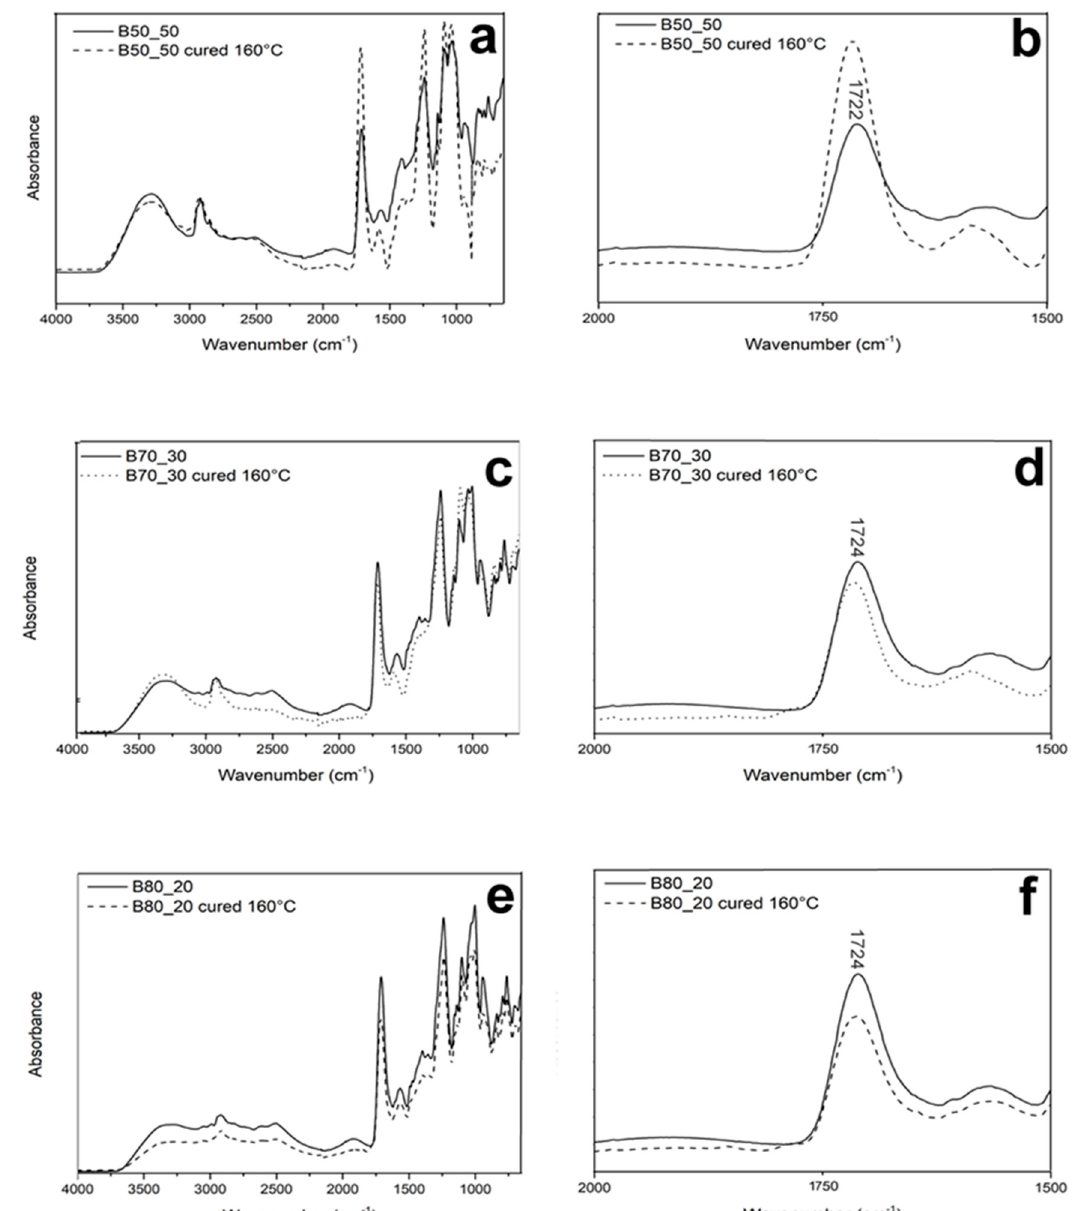
Figure 5. Full attenuated total reflectance mode (ATR-FTIR) spectra of as-spun and cured fibers: B50_50 ( a ), B70_30 ( c ), and B80_20 ( e ). Magnification of the C = O stretching: B50_50 ( b ), B70_30 ( d ), and B80_20 ( f ).